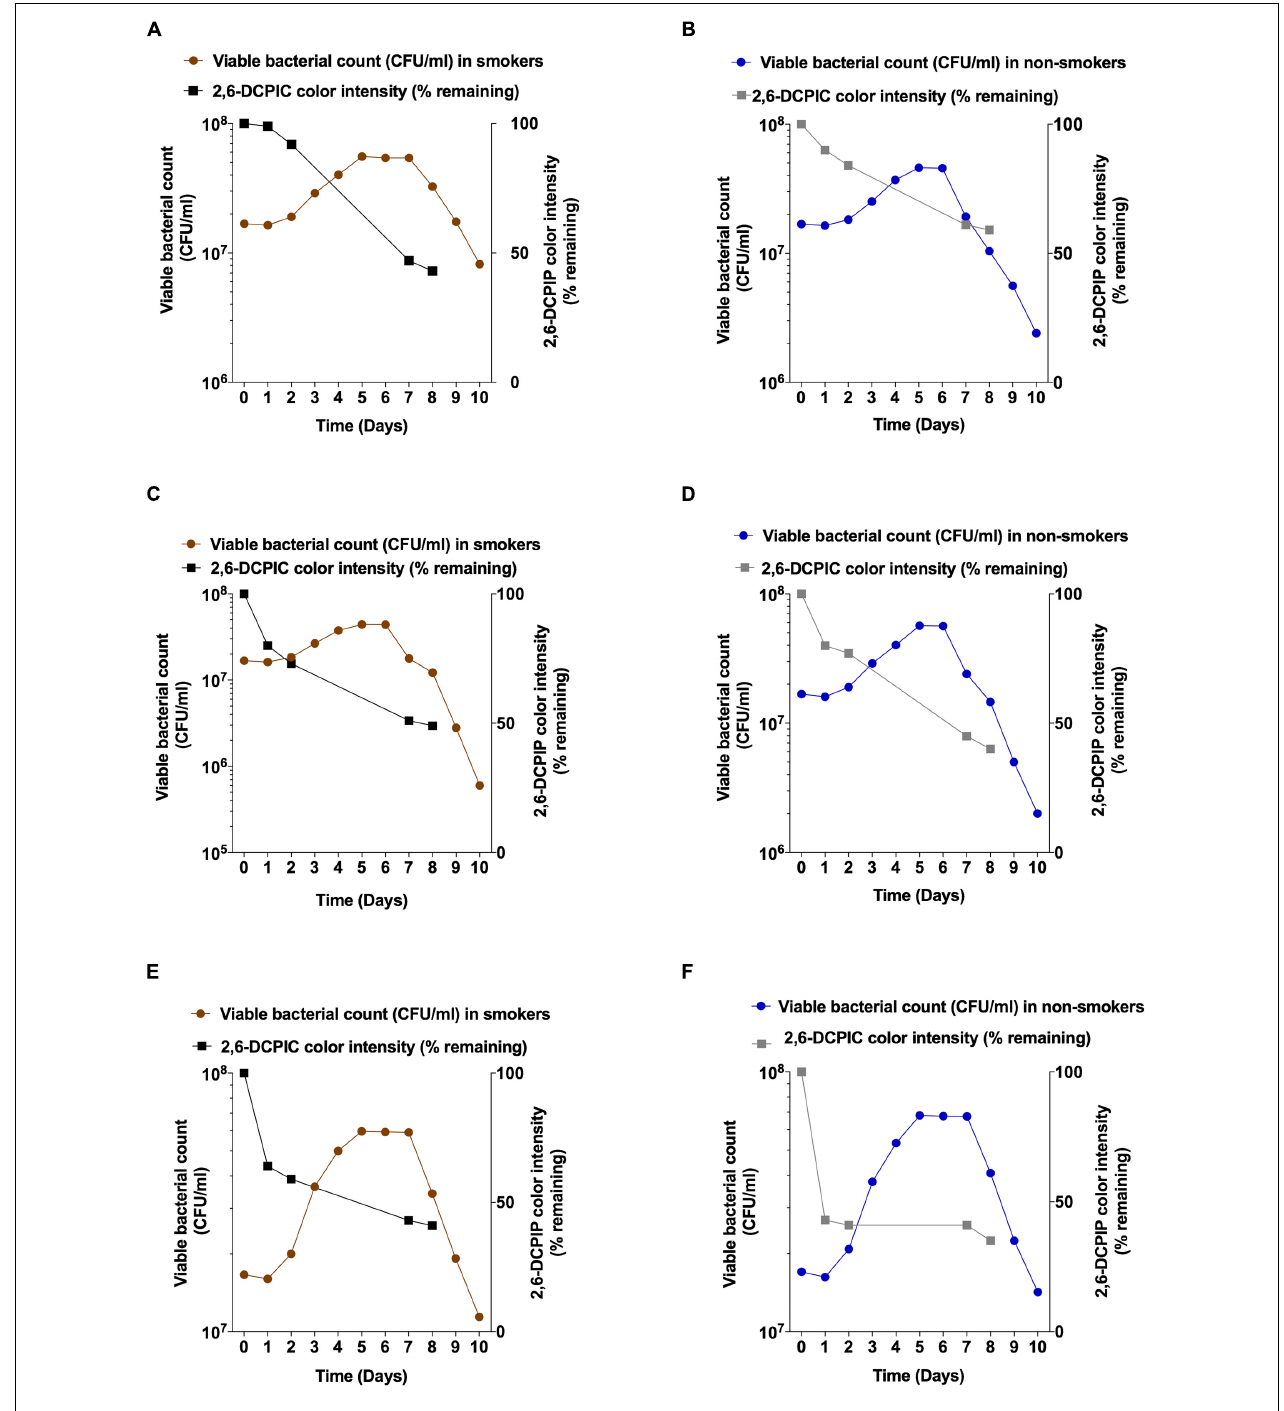
FIGURE 5 | Viable counts and anthracene biodegradation by selected bacteria isolated from representative smoker and non-smoker participant over a period of 10 days. S. mutans from (A) smokers and (B) non-smokers (C) L. fermentum from smoker; (D) L. salivarius from non-smoker; (E) V. tobetsuensis from smoker; (F) V. parvula from